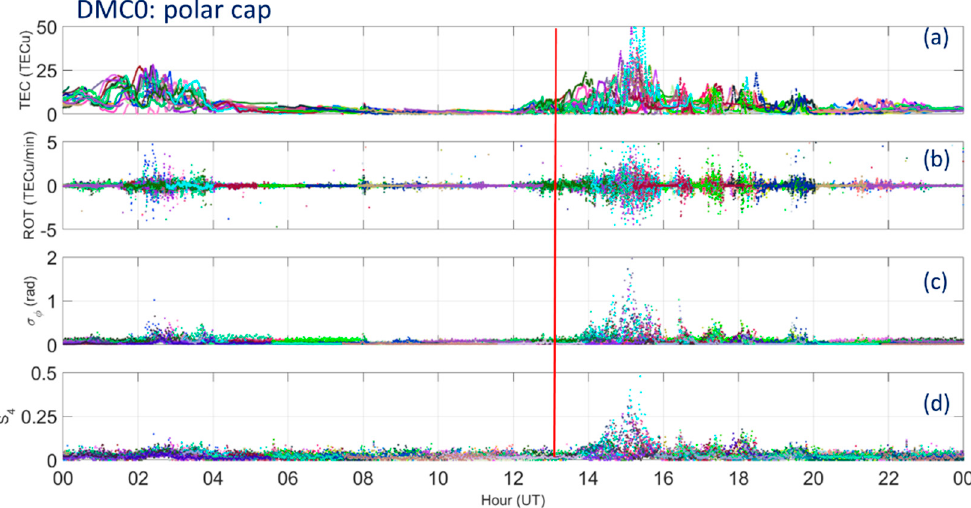
Figure 3. GNSS data from the receiver located at Concordia station (DMC0) on 8 September 2017. From top to bottom: Total Electron Content (TEC, a ), Rate of TEC change (ROT, b ), phase scintillation index ( σ φ , c ) and amplitude scintillation index ( S 4 , d). Different colors refer to different satellites in view of the receiver. Red vertical line highlights the local magnetic noon.